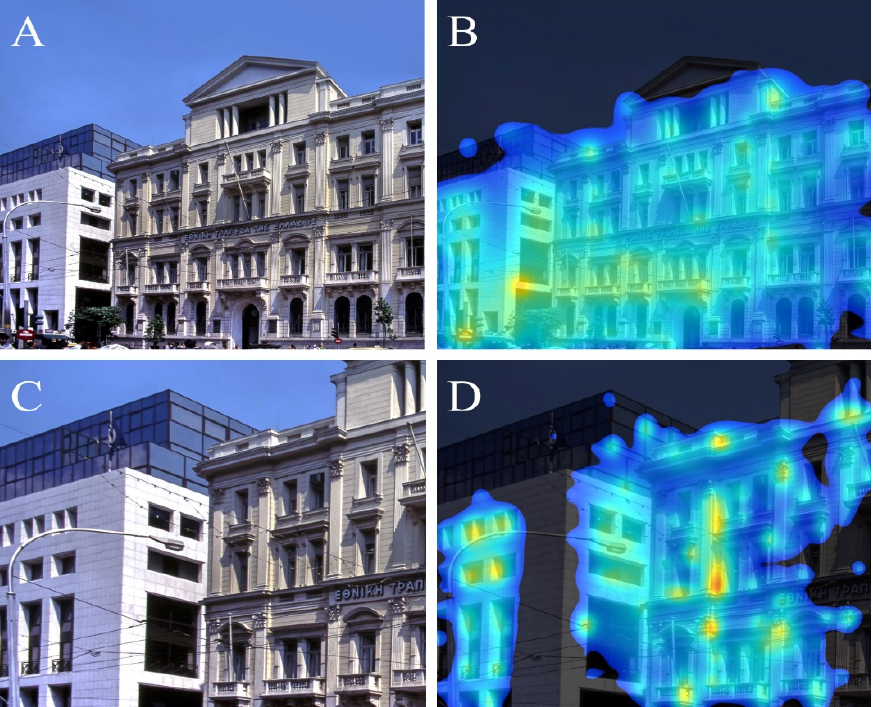
Figure 6. ( A ) The neoclassical building of the National Bank of Greece, built in the late 19th and extended in the early 20th century (right), and part of the modernist-style building of the Alpha Bank, from the 1990s (left) in Stadiou Street, Athens, Greece, with ( B ) eye-tracking simulation heatmap. ( C , D ): zoomed-in view leading to a new and distinct heatmap.